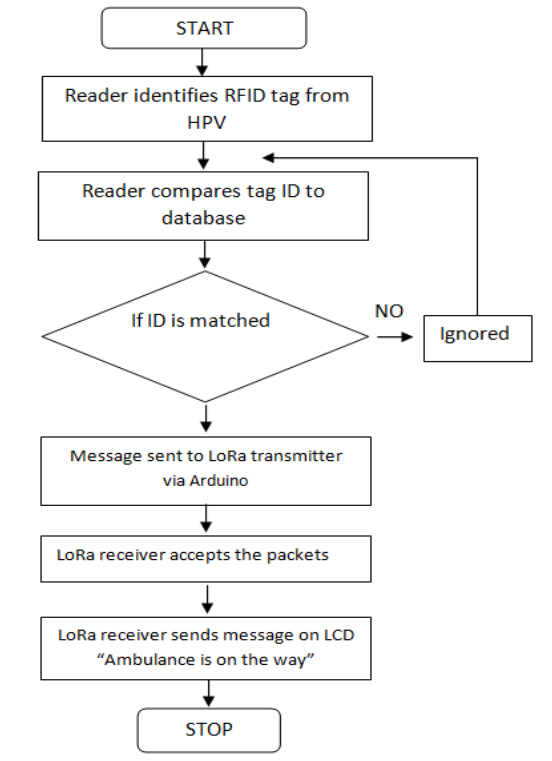
Fig. 2. Functional flow diagram of the proposed